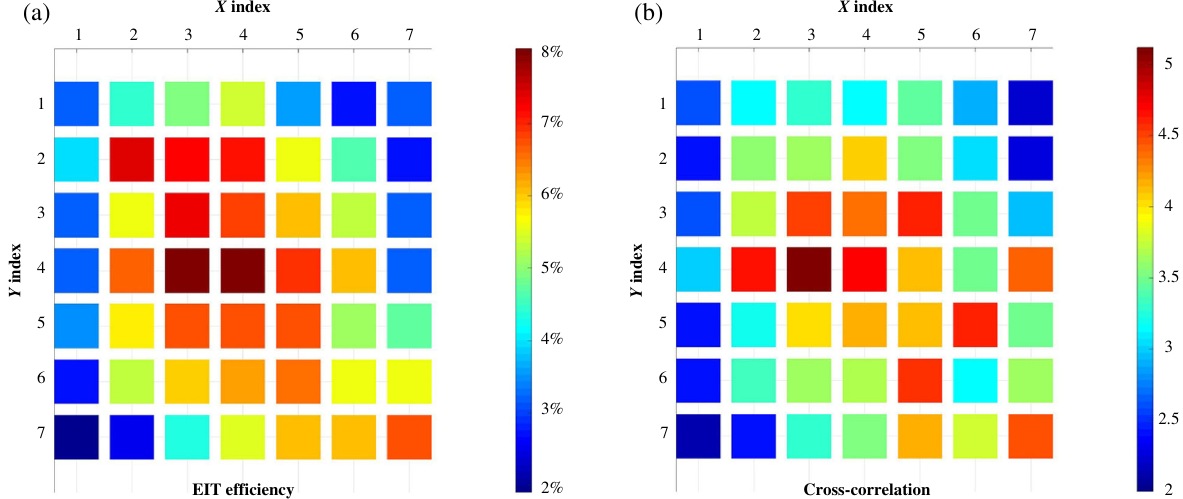
FIG. 4. Retrieval efficiency for the idler photon from each memory cell and its quantum correlation with the signal photon after 10-km transmission. (a) Retrieval efficiency for the idler photon stored in each of the 7 × 7 memory cells. The storage time is 650 ns. (b) The measured intensity cross-correlation g between the retrieved photon from each memory cell and the signal photon after the 10-km c transmission. The measurement bases are j V i for the transmitted signal photon and j H i for the retrieved t r